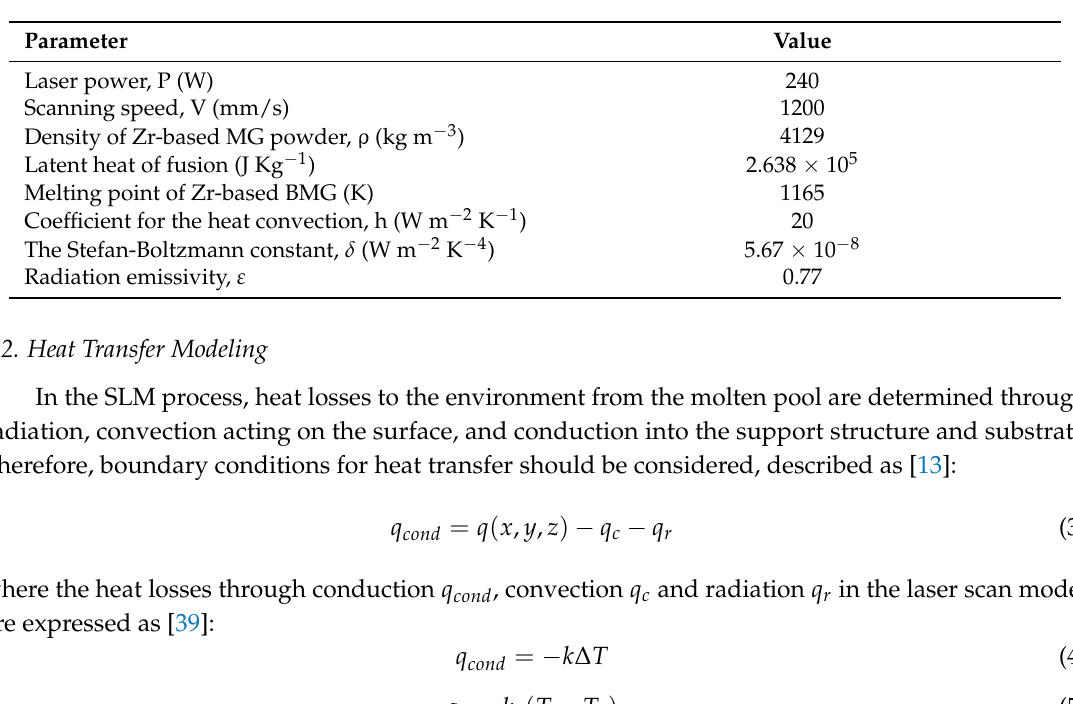
Table 1. Parameters used for finite element